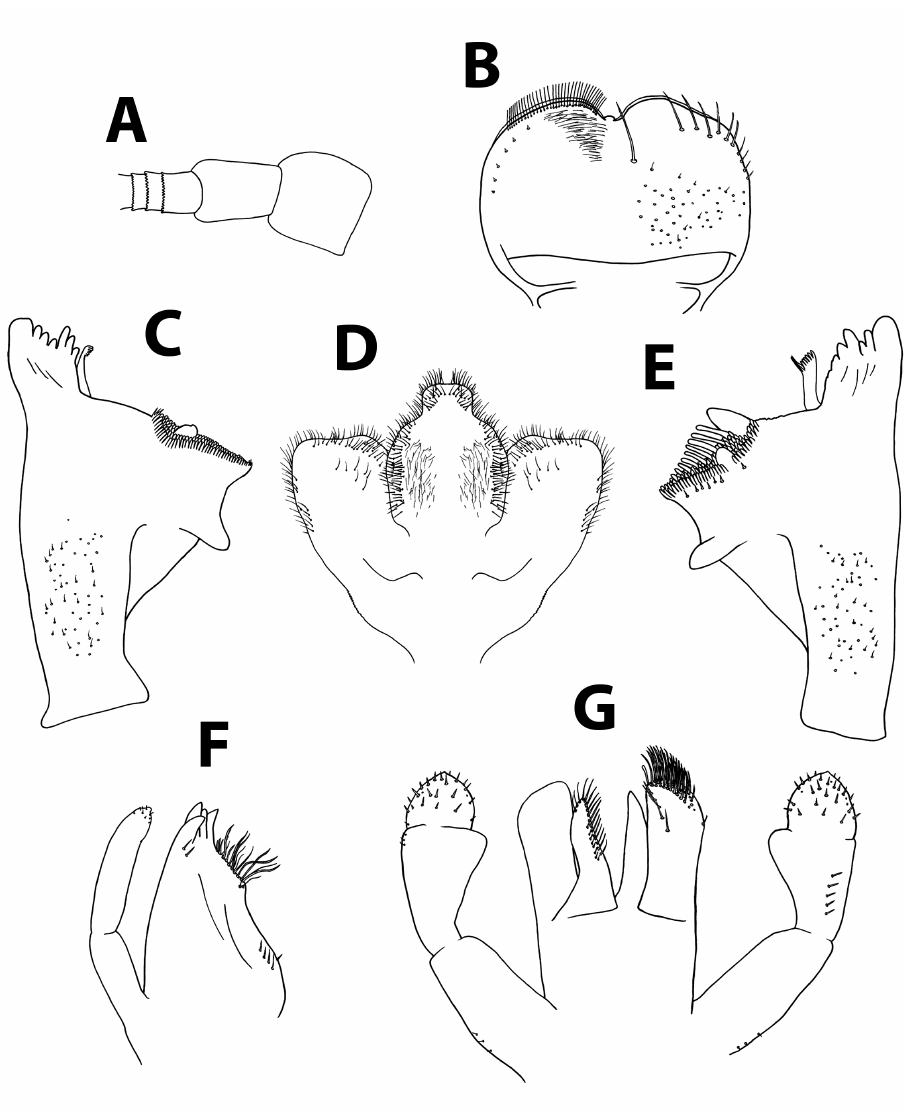
Figure 5. Baetis aureus sp. n., nymph. A antennal scape, pedicel and first flagellomeres B labrum (left, ventral; right, dorsal) C right mandible D hypopharynx E left mandible F maxilla G labium. spaces between them no broader than spine length (Figure 6C). Gill I oval, reduced, without marginal spines and visible tracheation (Figure 6D); gills II to VII elongate, 1.7 times longer than following tergum; margins thicker with very fine serration in proximal half; branched tracheae clearly visible (Figure 6E). Paraproct (Figure 6F) with elongate scales, hair-like setae and seta bases; margin with 20–30 regular triangular spines; postero-lateral extension with few scales, margin with 14–20 triangular spines of similar